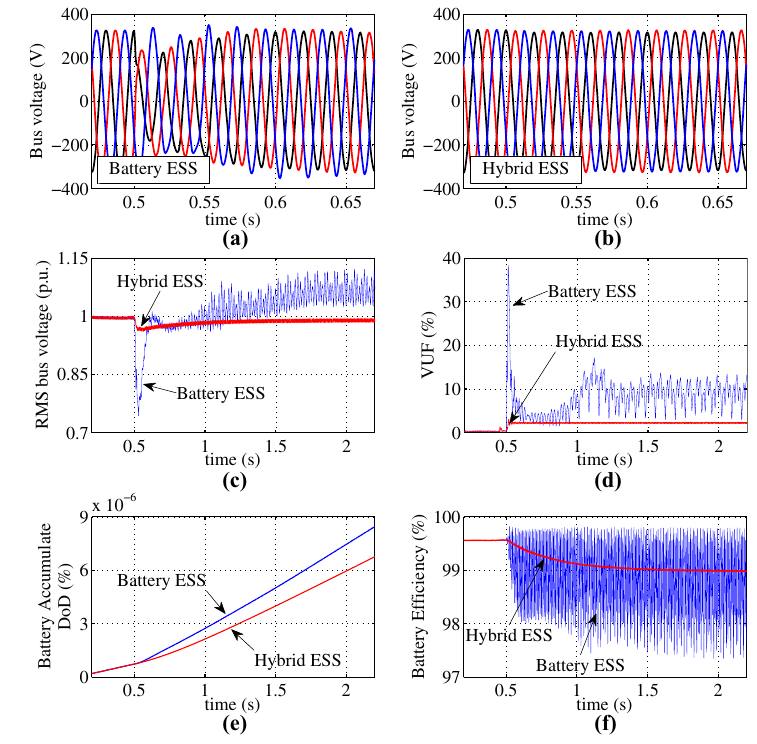
Figure 8. Simulation comparison between battery ESS and hybrid ESS in a standalone microgrid under single